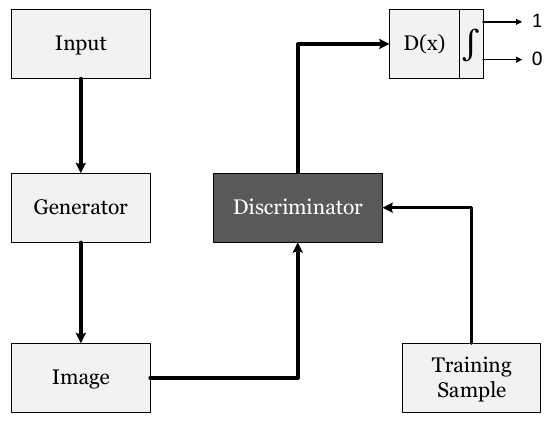
Figure 20. Illustration of generative adversarial network (GAN)